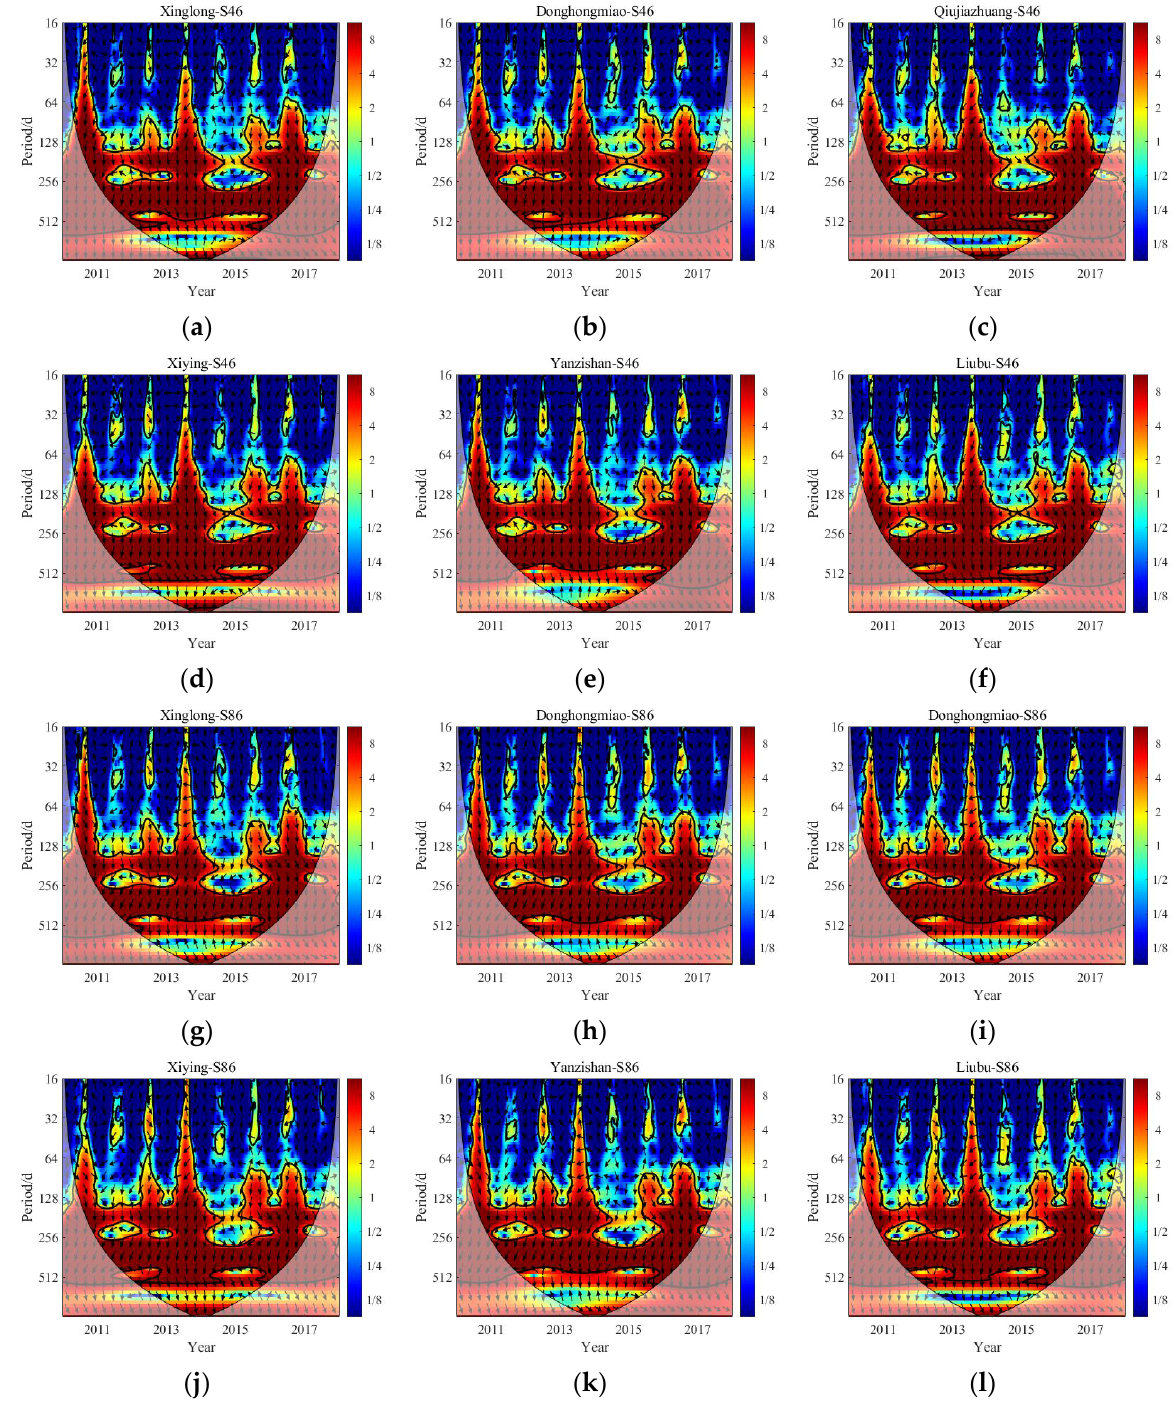
Figure 6. The XWTs of precipitation and groundwater level. ( a – f ) six precipitation stations and S46; ( g – l ) six precipitation stations and